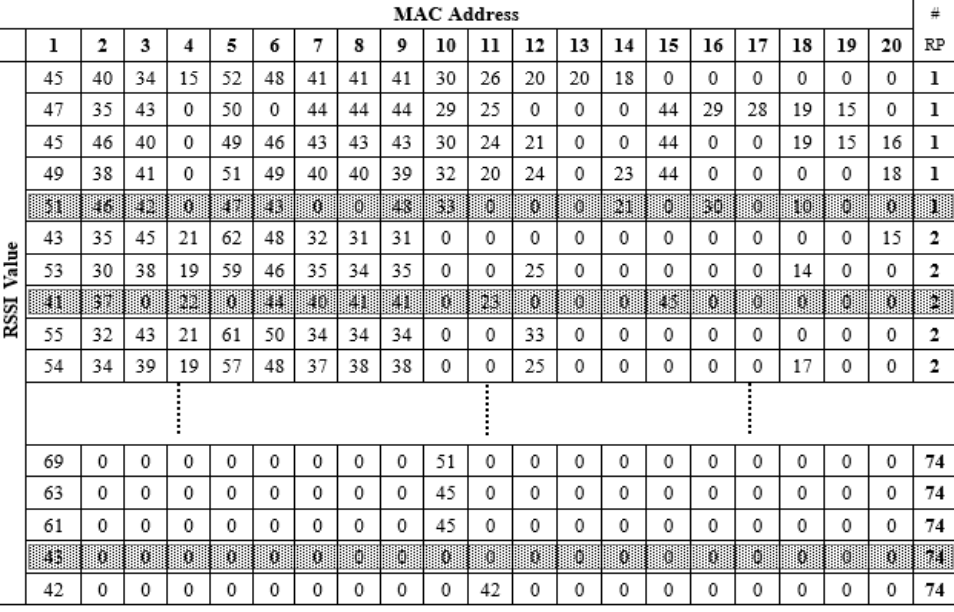
Figure 8. Clustering-based noise elimination scheme (CNES)-based training dataset with the high- lighted and deleted noise points. Figure 8 shows the RSSI values of MAC addresses ranging from 1 to 20, taking the five sets of RSSI data samples for RP1, RP2, and RP74 as examples. The RSSI sample was the original CSV file generated from RSSI data collected in the experimental environment, which contained noise samples. When CNES is not used, direct use of the database will reduce the accuracy of indoor positioning. The grey, highlighted segments in Figure 8